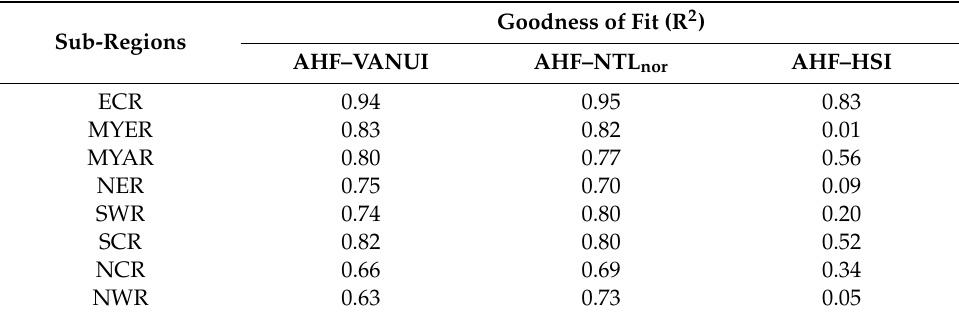
Table 4. Goodness of fit between indexes and